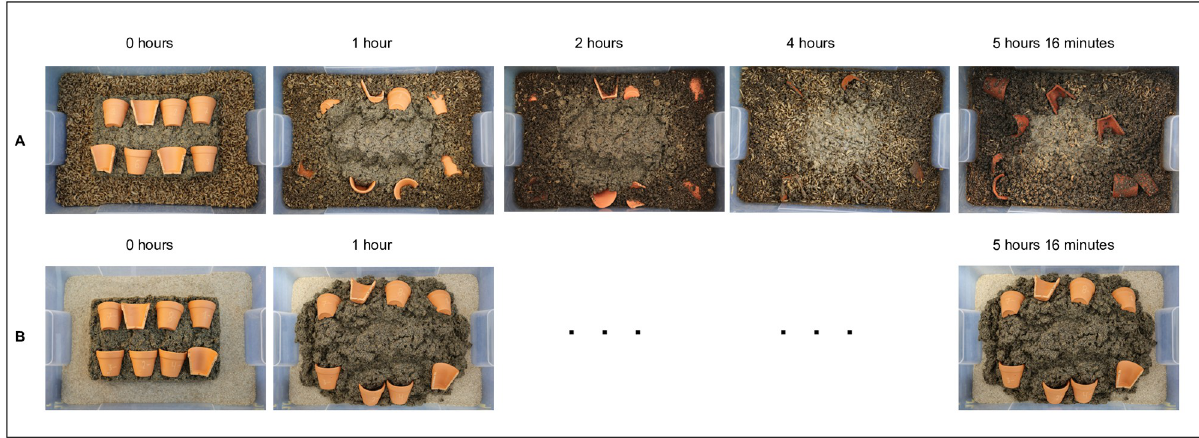
Fig 1. Snapshots of waste turnover and the burial of ceramics by black soldier fly larvae. Larvae of BSF (A) rapidly consume the Waste Model (WM = dog food + pig slurry) while burying ceramic sherds, whereas (B) no sign of bioturbation has been observed in the control treatments.